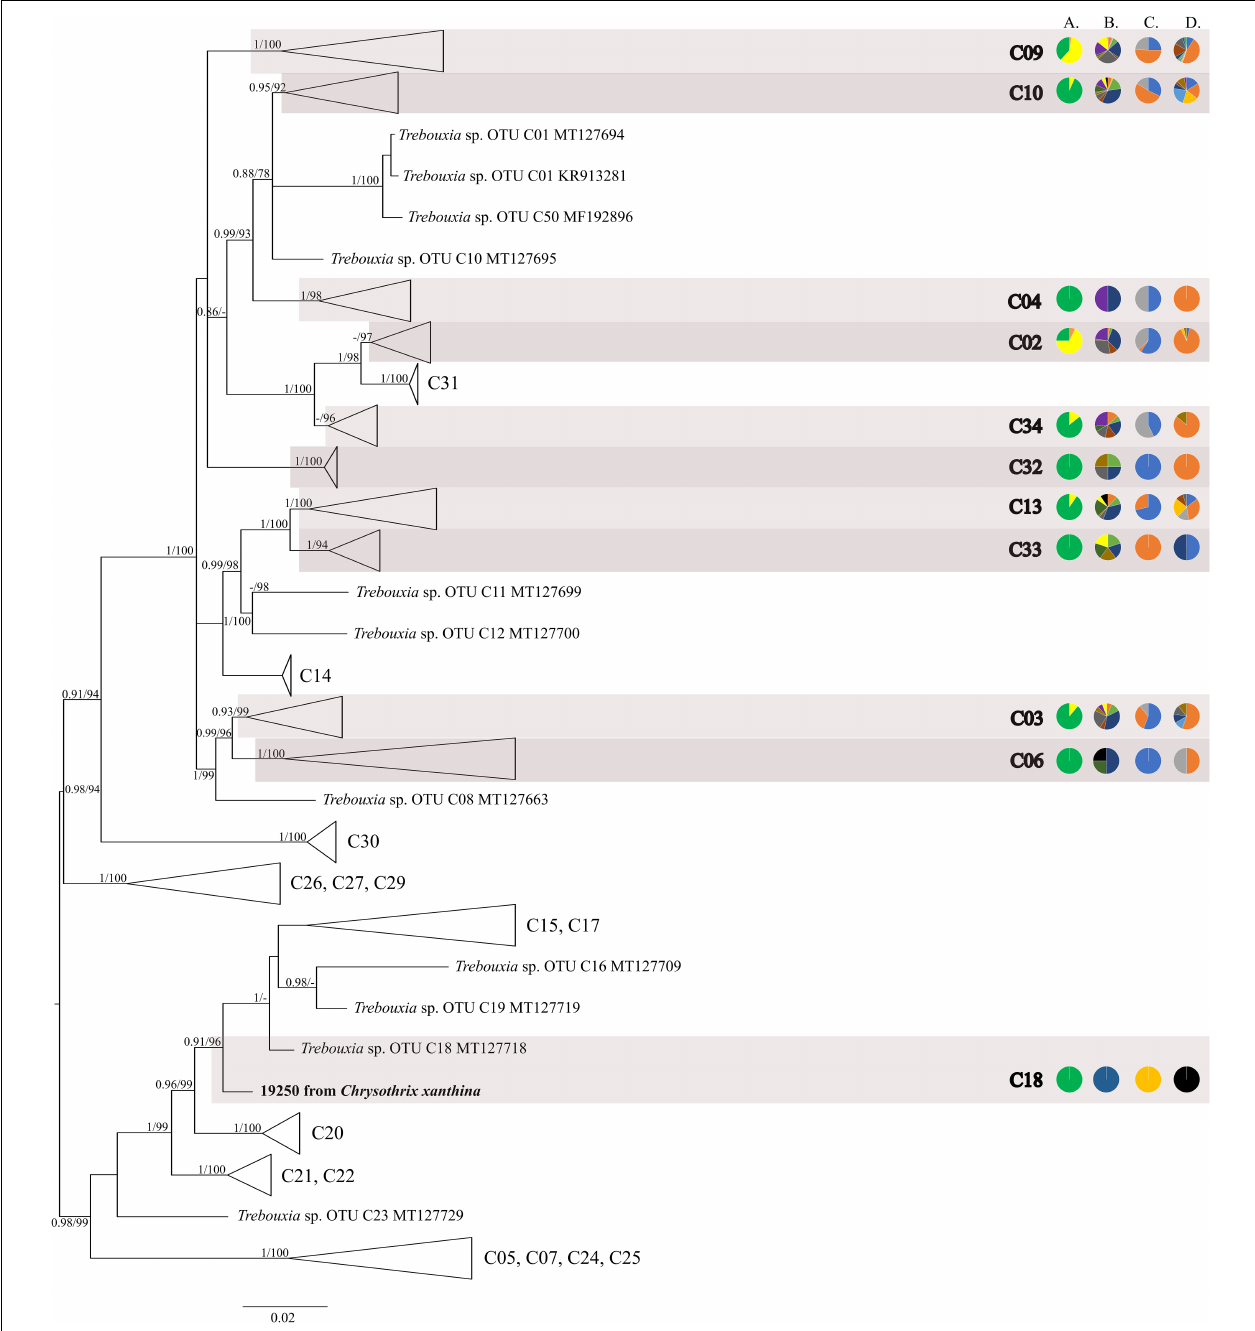
FIGURE 2 | Collapsed majority-rule consensus tree from Bayesian analysis of Trebouxia clade C based on ITS rDNA and rbc L locus dataset with posterior probabilities and bootstrap support values from IQ-TREE analysis presented near the branches. For each record from GenBank, accession no. with photobiont name are given (following Škaloud et al., 2018; Muggia et al., 2020). For newly sequenced samples, voucher no. and their mycobiont host name are given. Newly sequenced photobionts from Bolivia are marked in bold. Species or phylogenetic lineages are marked in boxes with appropriate names. The first column of pie charts shows the percentage of specimens originating from open high Andean vegetation, upper montane cloud forest 2, upper montane cloud forest 1 and lower montane cloud forest in each Trebouxia lineage. The second column of pie charts shows the percentage of specimens in which defined groups of secondary metabolites were found in each Trebouxia lineage, absence of substances (A), presence of aliphatic (fatty) acids (B), anthraquinones (C), ergochromes (D), depsones (E), orcinol depsides (F), β -orcinol depsides (G), orcinol depsidones (H), β -orcinol depsidones (I), orcinol tridepsides (J), pulvinic acid derivatives (K), terpenoids (L), usnic acid derivatives (M), xanthones (N), and pigments (O). The next column of pie charts shows the percentage of specimens in each Trebouxia lineage with a given lichen growth form. In the last column of pie charts, the percentage of given lichen family is shown. The color scheme is explained in the legend on Figure 1 .